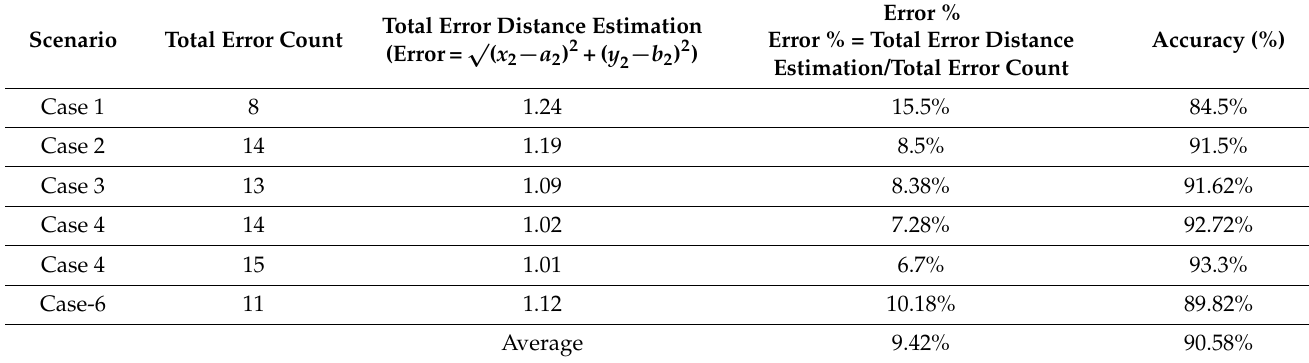
Table 4. Quantitative analysis used to calculate the accuracy using only MPC.